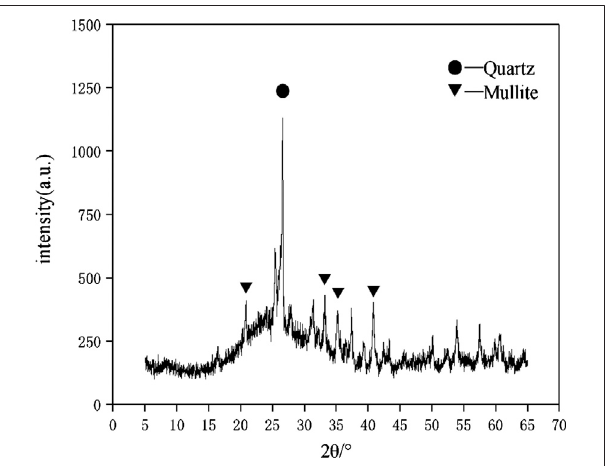
FIGURE1 | XRD diffractogram of red mud.